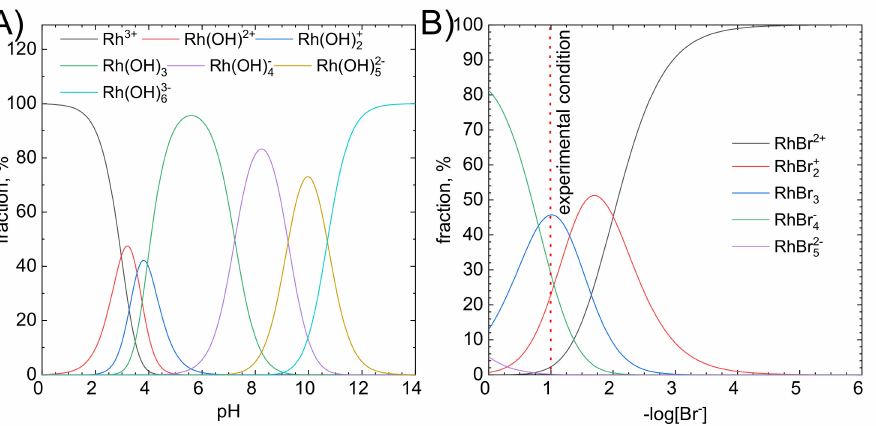
Figure 10. Speciation analysis of the solution, ( A ) pH impact on the complex structure and ( B ) bro- mide ions concentration impact on the complex